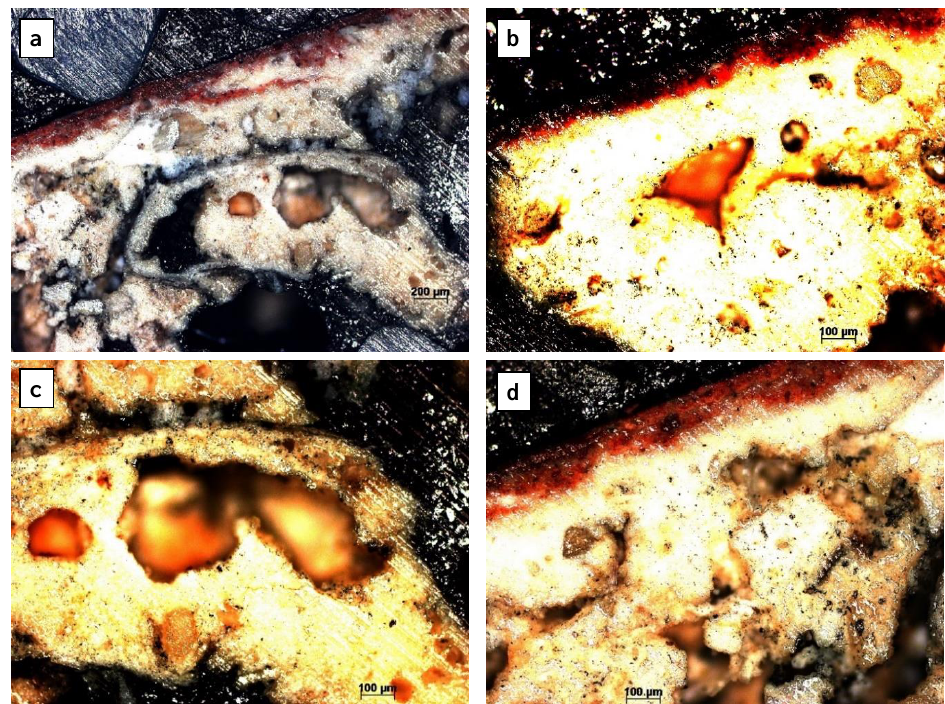
Figure 2. Fresco microstructure by polarized light microscopy (OMPL).